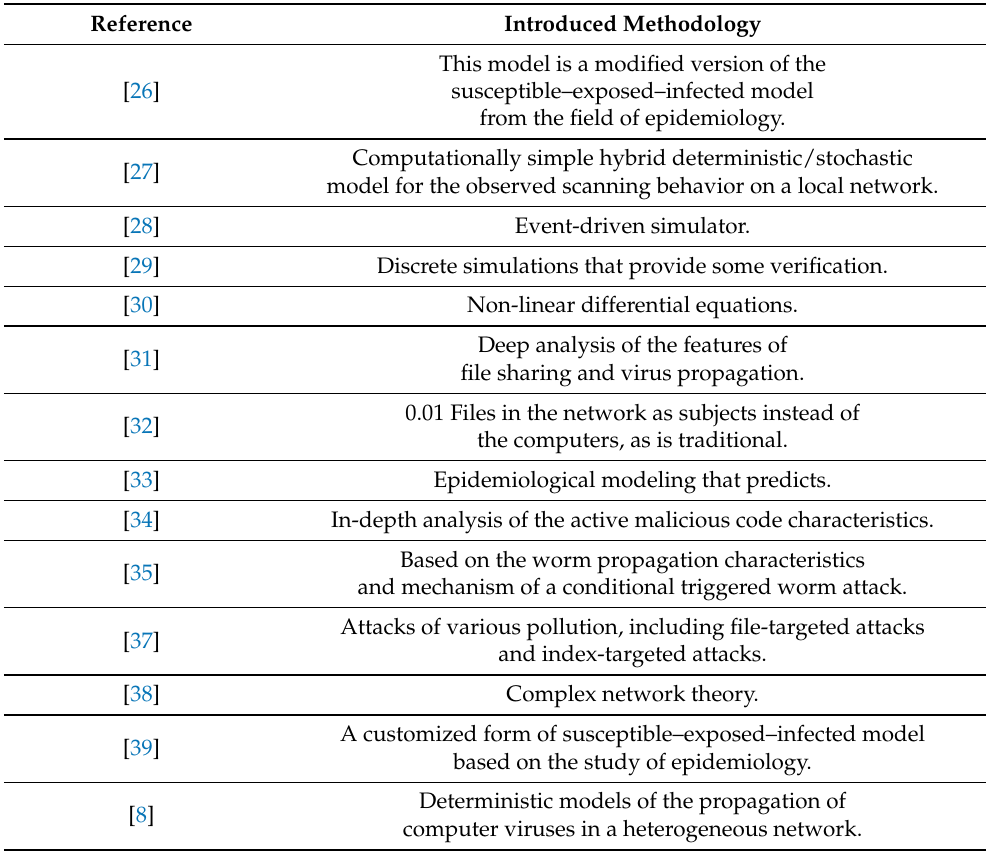
Table 1. Related work and introduced